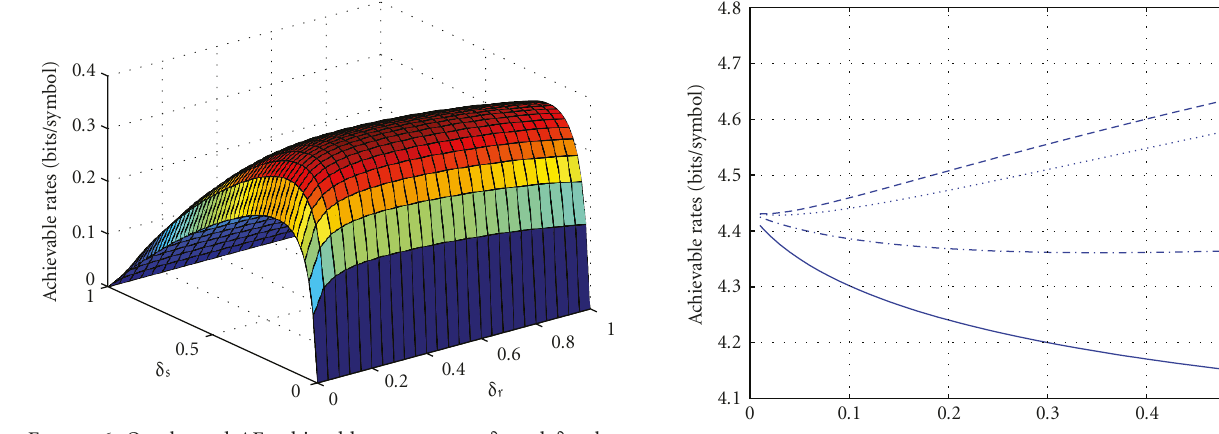
Figure 6: Overlapped AF achievable rates versus δ s and δ r when P s = P r = 0 . 5